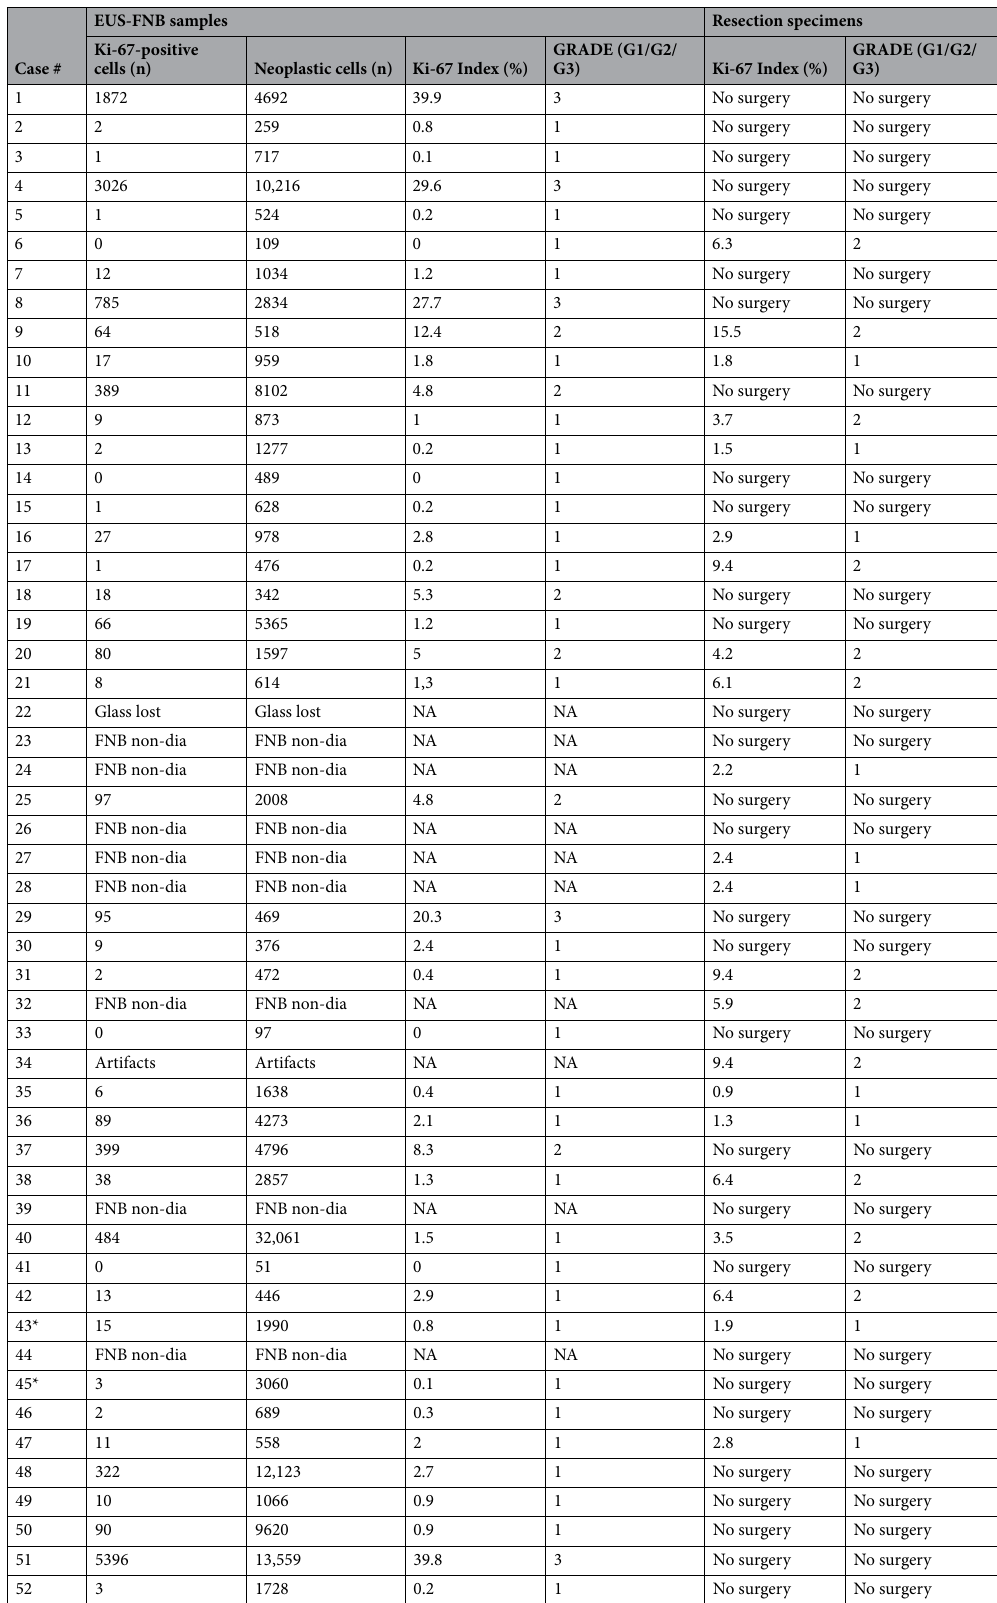
Table 2. The Ki-67 Index and tumor grade in EUS-FNB samples and resection specimens. *Cases presenting as a cystic PanNET with only a sparse solid